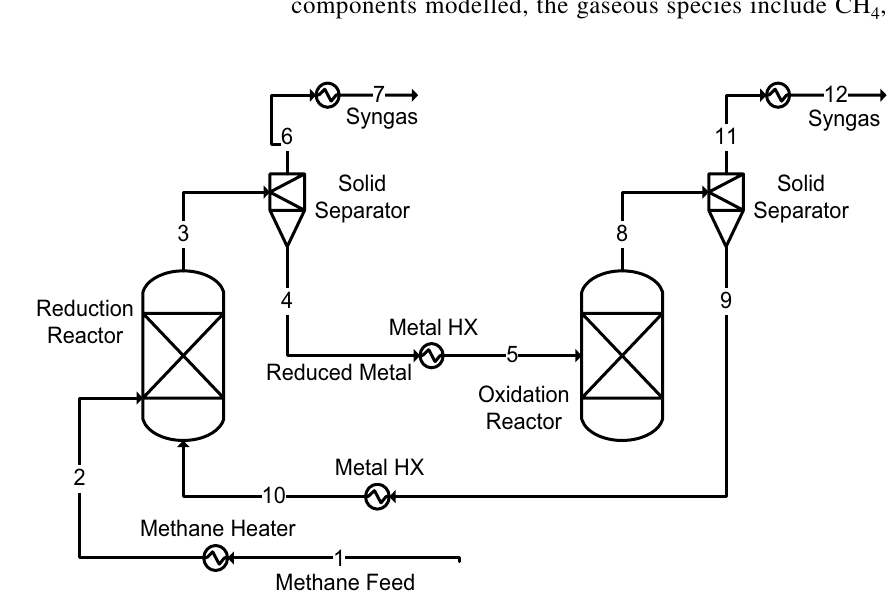
Fig. 2 Process simulation flowsheet of interconnected reduction and oxidation